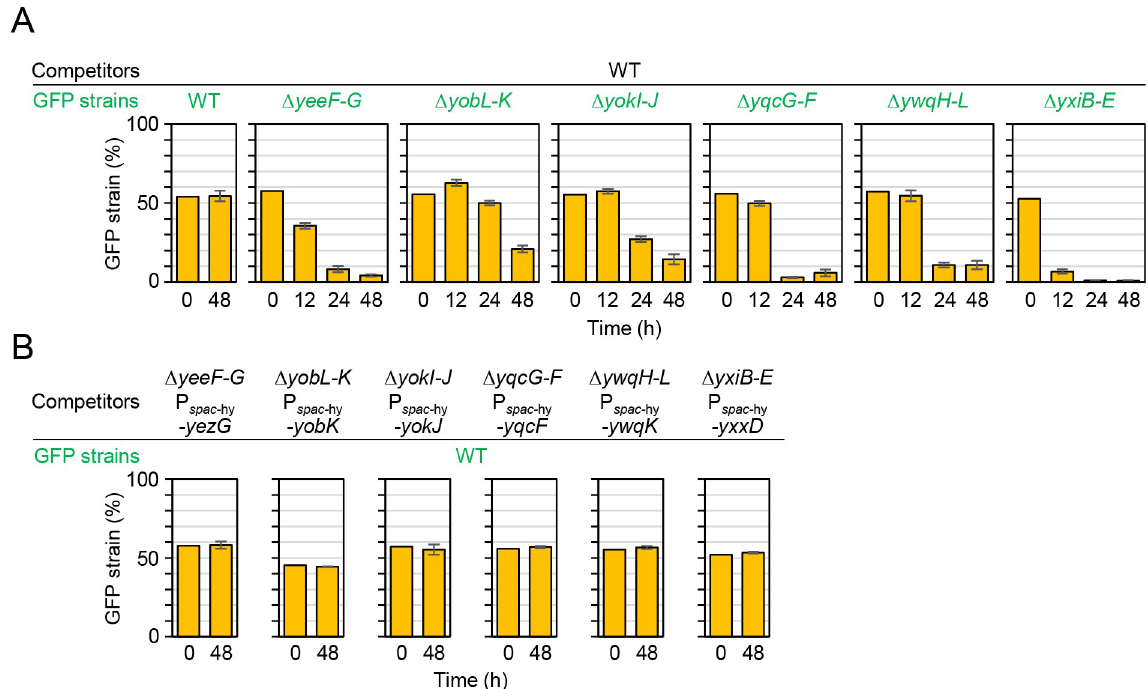
Fig 4. LXG toxins and antitoxins mediate intercellular competition. (A) Time-course analysis of competition. The wild-type strain and LXG toxin–antitoxin deletion mutants carrying a constitutively expressed gfp reporter (GFP strains) were grown to an OD 600 of 0.7–0.8. and precisely diluted cultures (OD 600 of 0.5) of the wild-type and one of the mutants were mixed at a 1:1 ratio. Exact proportions of the GFP strains in the mixtures were determined by flow cytometry and used as time 0 samples. The mixtures were spotted onto solid MSgg medium, and the inoculated plates were then incubated at 30˚C. The proportion of GFP-reporter strains within colonies at each time point was determined by flow cytometry using three independent colonies. Percentages are presented as mean ± standard deviation ( n = 3). (B) Inducing antitoxins restored competitiveness to toxin–antitoxin deletion mutants. Antitoxin genes were ectopically induced from the IPTG-dependent spac -hy promoter at the amy locus of mutant chromosomes. The indicated strains were co-cultured on MSgg supplemented with 0.1 mM IPTG. Percentages are presented as mean ± standard deviation ( n =